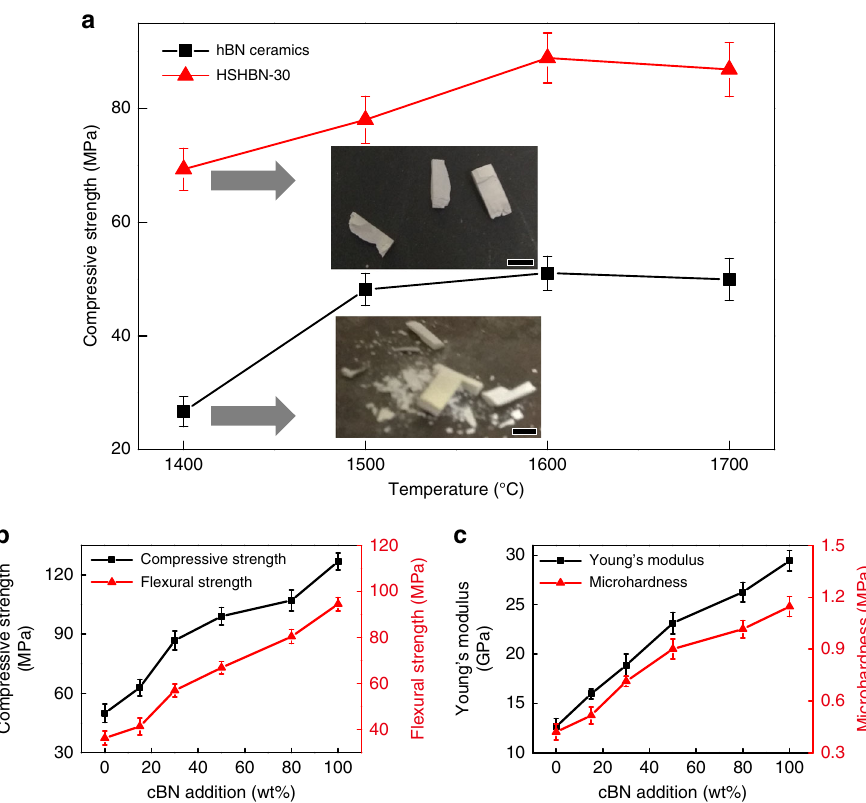
Fig. 6 Mechanical properties of HSHBN samples. Plot showing the dependence of compressive strength on sintering temperature for both the pure hBN and HSHBN-30 ceramics, and photographs show the 1400 °C-sintered samples after testing, and all scale bars represent 6 mm ( a ); compressive and fl exural strength ( b ), Young ’ s modulus and microhardness measurements ( c ) of the 1700 °C-sintered pure hBN ceramics and HSHBNs. All the error bars represent standard deviations, and n =